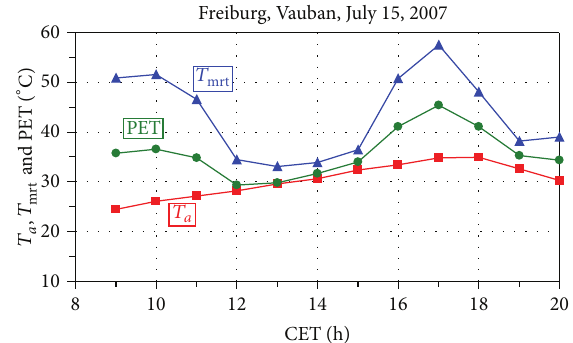
Figure 6: 1h mean values of air temperature 𝑇 𝑎 , mean radiant , and physiologically equivalent temperature PET temperature 𝑇 mrt at the NNE-facing sidewalk of a WNW-ESE street canyon, “Vauban” quarter in Freiburg during typical Central European summer day.